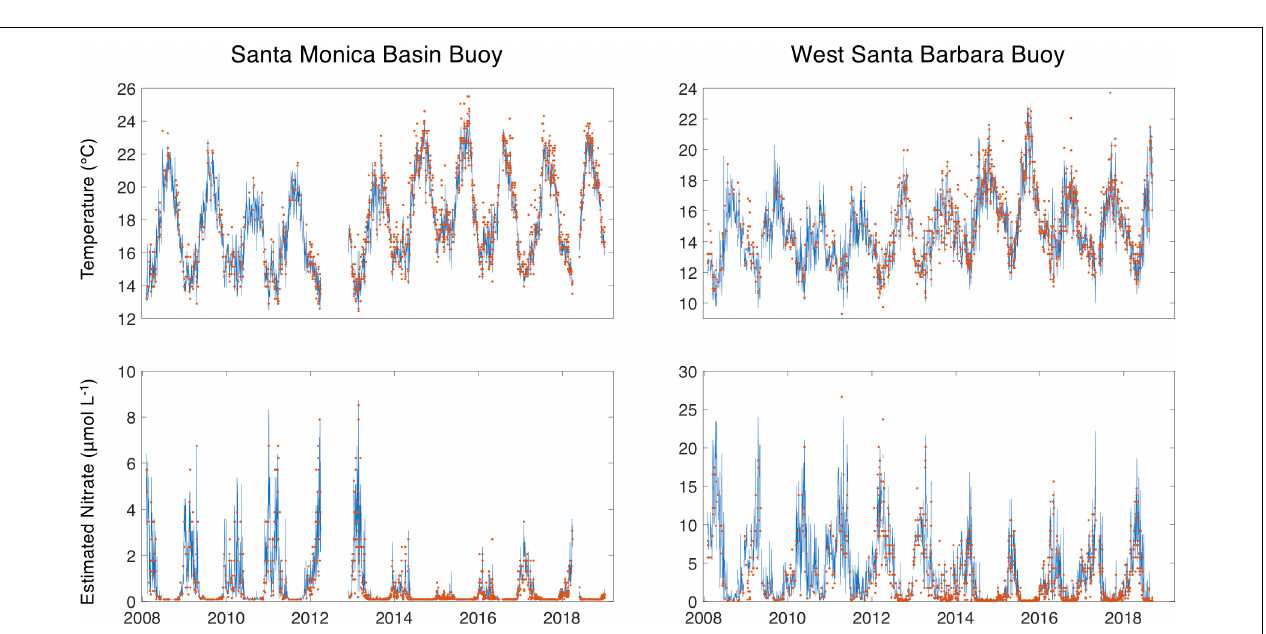
FIGURE 6 | Continuous temperature and estimated nitrate concentrations time series from the Santa Monica Basin and West Santa Barbara buoys are shown as blue lines. The red dots show the daily SST and daily estimated nitrate concentrations from the 1 km, MODIS/VIIRS-derived SST